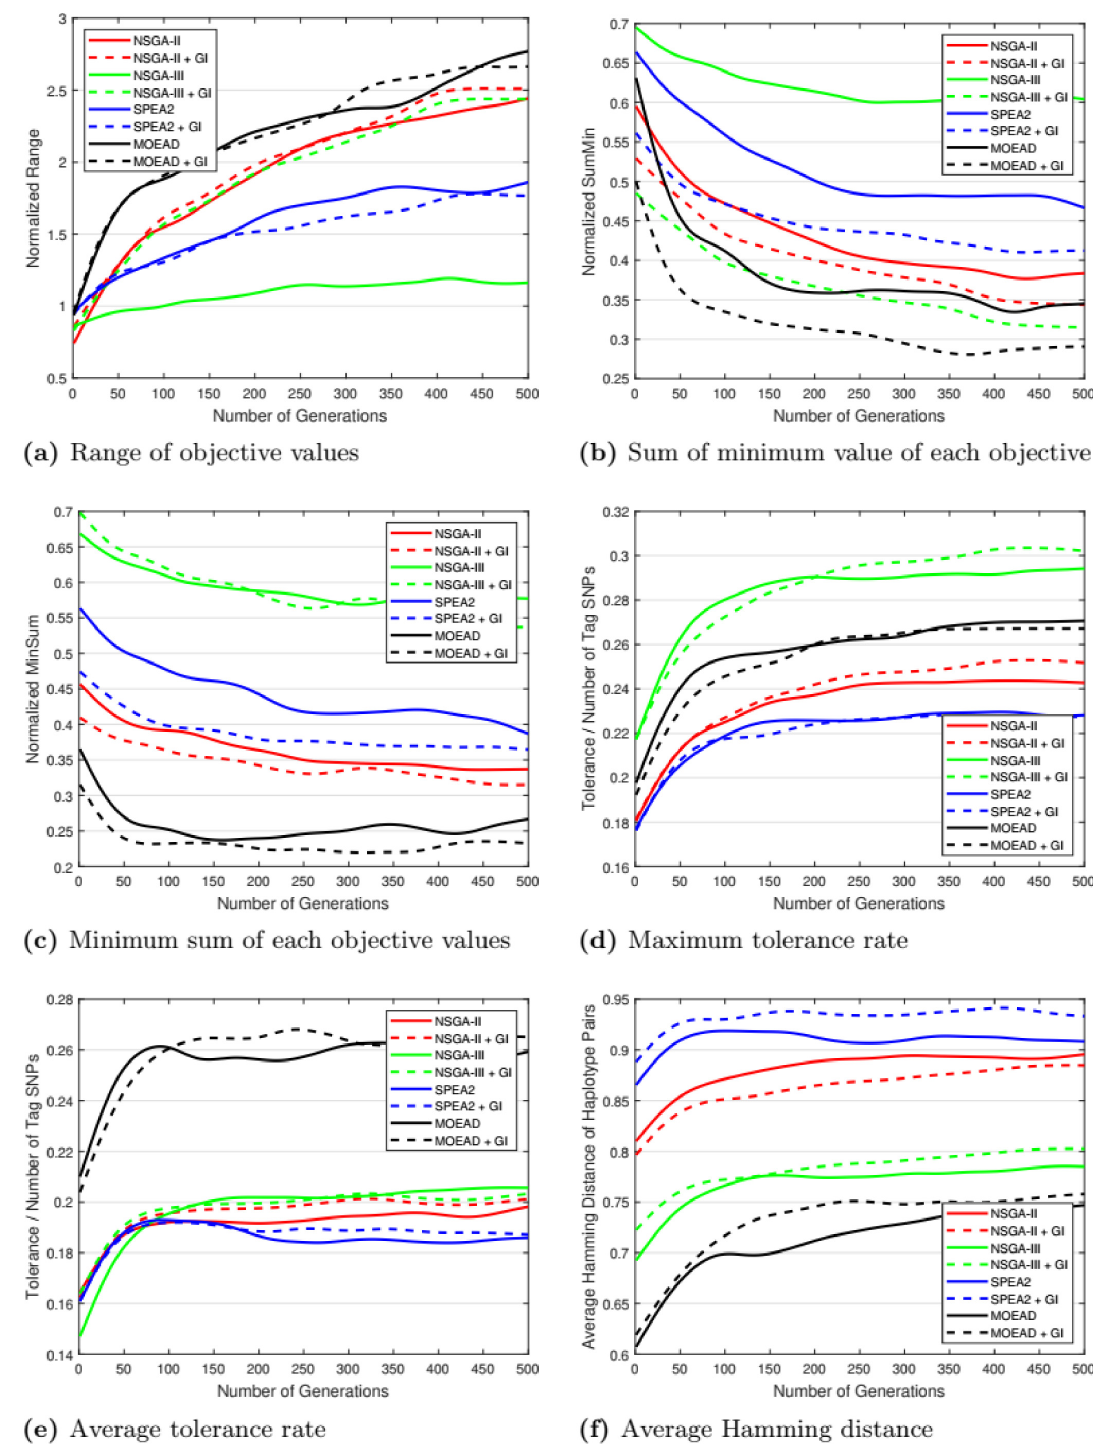
Fig 9. Performance comparison of algorithms. GI stands for greedy initialization. (a) Range of objective values, (b) Sum of minimum value of each objective, (c) Minimum sum of each objective values, (d) Maximum tolerance rate, (e) Average tolerance rate, (f) Average Hamming